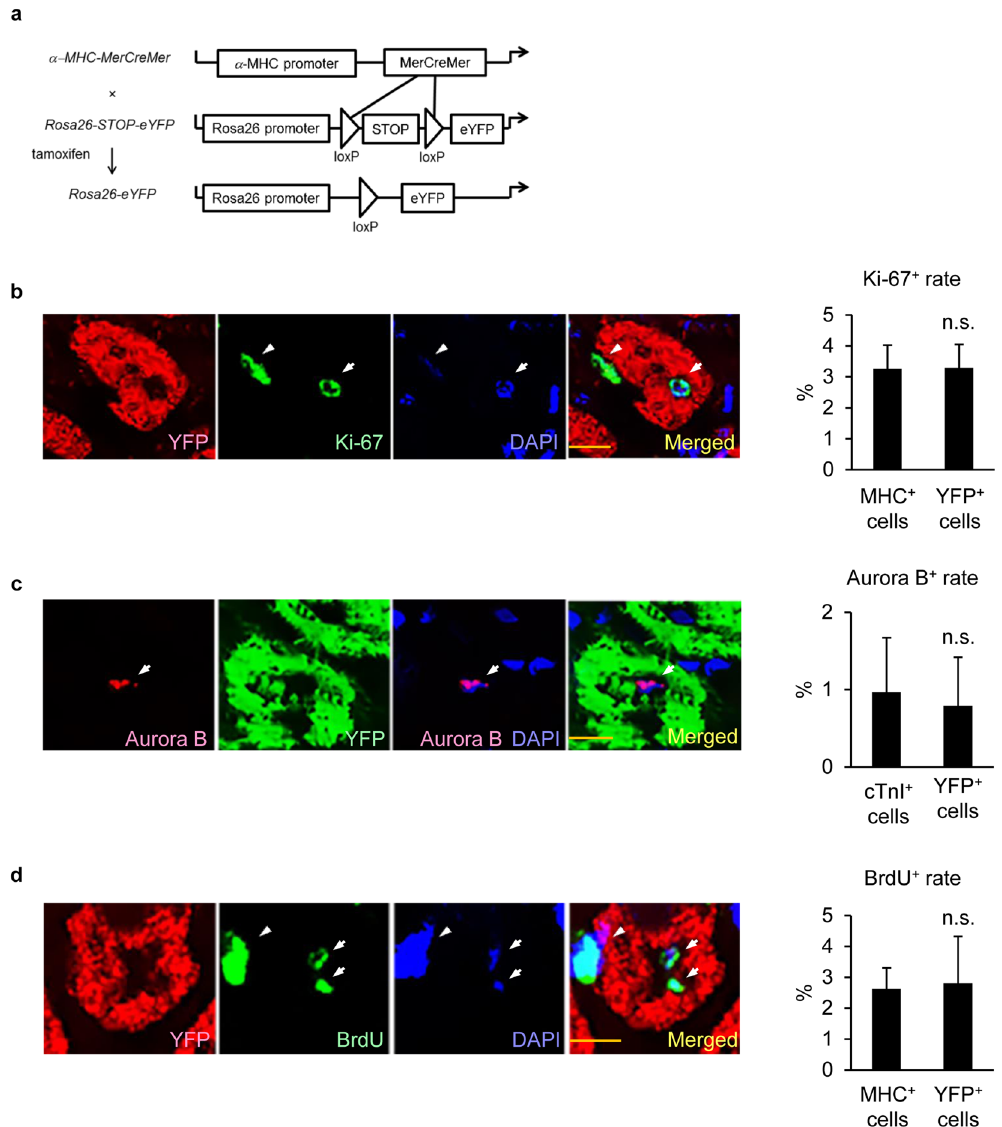
Figure 3. Proliferative cardiomyocytes were derived from pre-existing myocytes in EAM. ( a ) Tamoxifen was injected to double transgenic mice with α -MHC-MerCreMer and Rosa26-STOP-eYFP to label pre-existing cardiomyocytes with eYFP before EAM induction. ( b ) Heart sections were immunostained with anti-Ki-67 and anti-MHC or YFP antibodies at EAM3w. Left: representative images of a Ki-67 + YFP + cell are shown. Arrows: a Ki-67 + nucleus in a YFP + cell. Arrowheads: a Ki-67 + nucleus in a YFP − cell. Scale bar: 10 μ m. Right: Ki- 67 + MHC + and Ki-67 + YFP + cells in the inflamed region were counted and shown as percentage in MHC + and in YFP + cells, respectively. n = 4 mice for each group. ( c ) Heart sections were immunostained with anti-Aurora B and anti-cTnI or YFP antibodies at EAM3w. Left: representative images of an Aurora B + YFP + cell are shown. Arrows: an Aurora B + nucleus in a YFP + cell. Scale bar: 10 μ m. Right: Aurora B + cTnI + and Aurora B + YFP + cells in the inflamed region were counted and shown as percentage in cTnI + and in YFP + cells, respectively. n = 4 mice for each group. ( d ) BrdU was intraperitoneally injected four times at EAM3w. Heart sections were immunostained with anti-BrdU and anti-MHC or YFP antibodies 24 hours after the last injection. Left: representative images of a BrdU + YFP + cell are shown. Arrows: BrdU + nuclei in a YFP + cell. Arrowheads: a BrdU + nucles in a YFP − cell. Scale bar: 10 μ m. Right: BrdU + MHC + and BrdU + YFP + cells in the inflamed region were counted and shown as percentage in MHC + and in YFP + cells, respectively. n = 4 mice for each group. ( b – d ) Welch’s t -test. Data are shown as mean ±